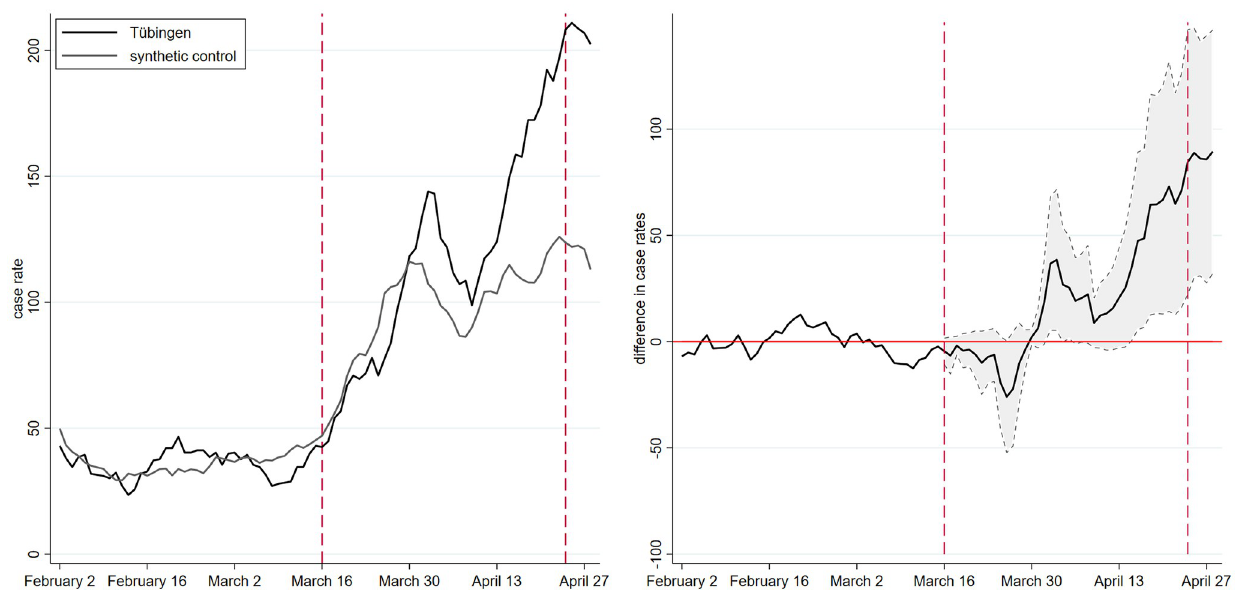
Fig 1. Seven-day case rates of Tu¨bingen and control group.